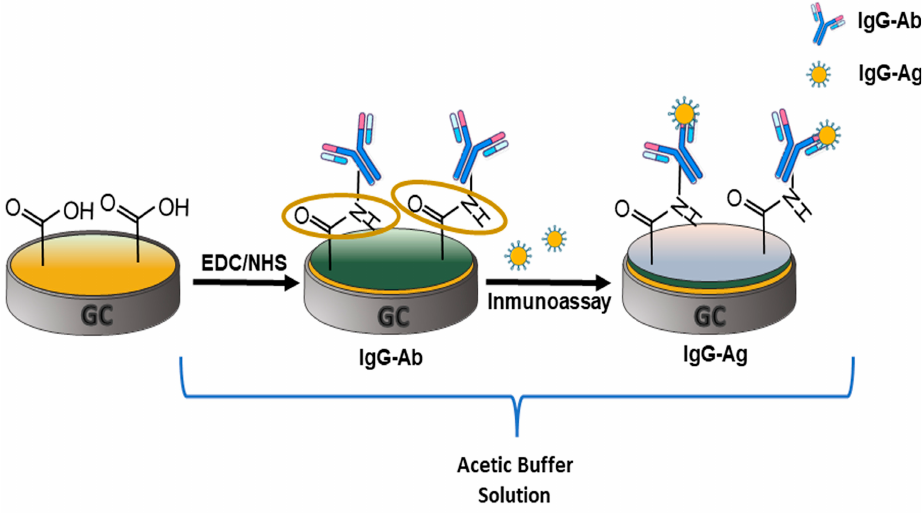
Figure 2. Schematic fabrication protocol of the electrochemical immunosensor for the detection of IgG-Ag.